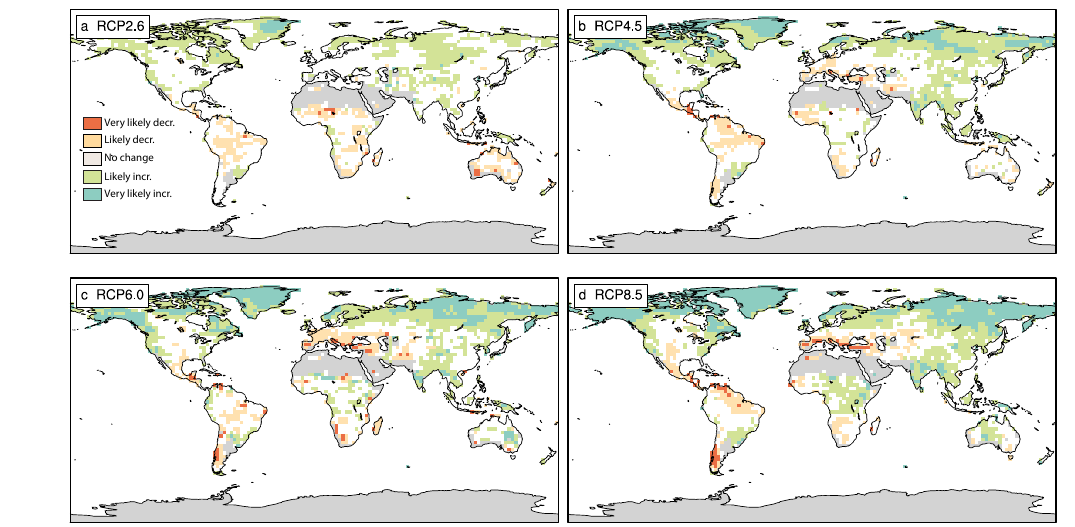
Figure 6. Conceptual summary of the probability that the slope of P − E is negatively/positively different from zero considering all climate models and (a) the RCP2.6, (b) the RCP4.5, (c) RCP6.0 and (d) RCP8.5 emission scenarios only. See Fig. 4 for